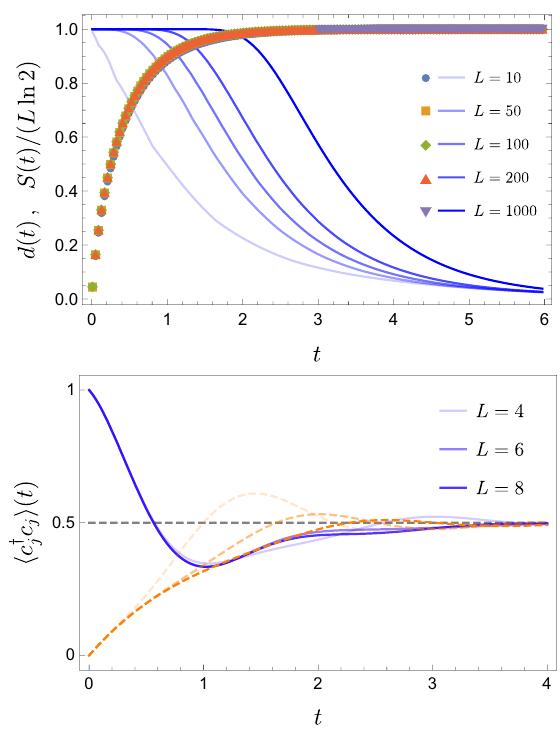
Figure 8: (Left) Evolution of the distance to equilbrium (blue curves) and the von Neumann entropy (colored dots) of the slowest-mixing state for various system sizes in the gain-loss model with γ = 0.5. (Right) Evolution of the fermion occupation number at site L (blue curves) and in the middle of the chain (orange curves) for the gain / loss model with α = 0, h = 0, γ = 0.5, starting from the state with one particle at site L and zero